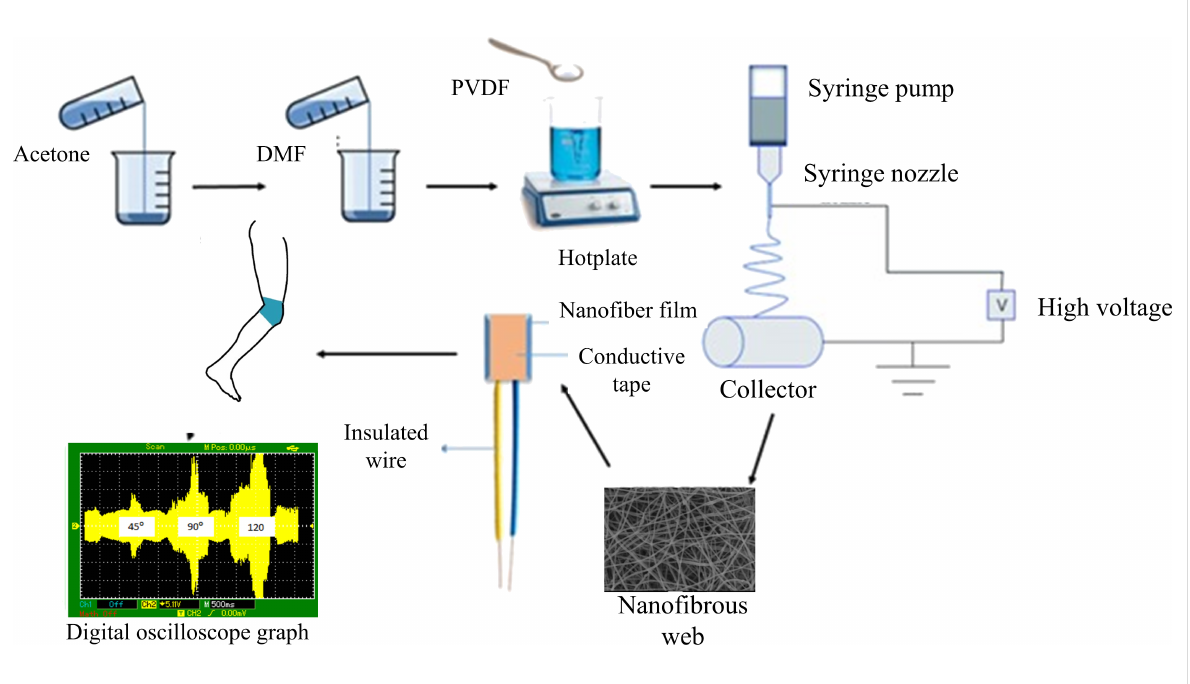
Figure 1: Illustration representing the scheme for sensor